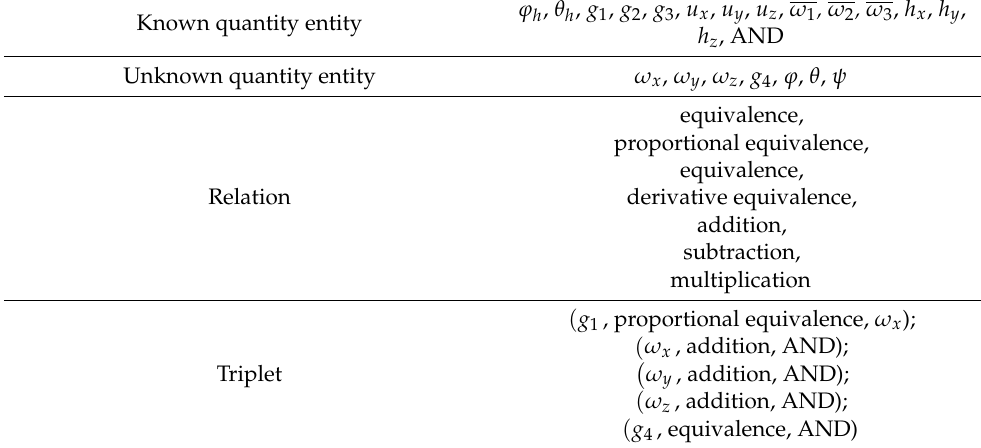
Table 1. Triple set of spacecraft control system model.